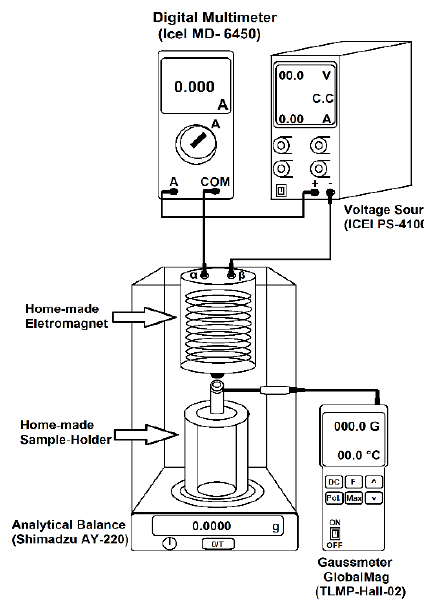
Figure 1. Magnetic force test scheme.